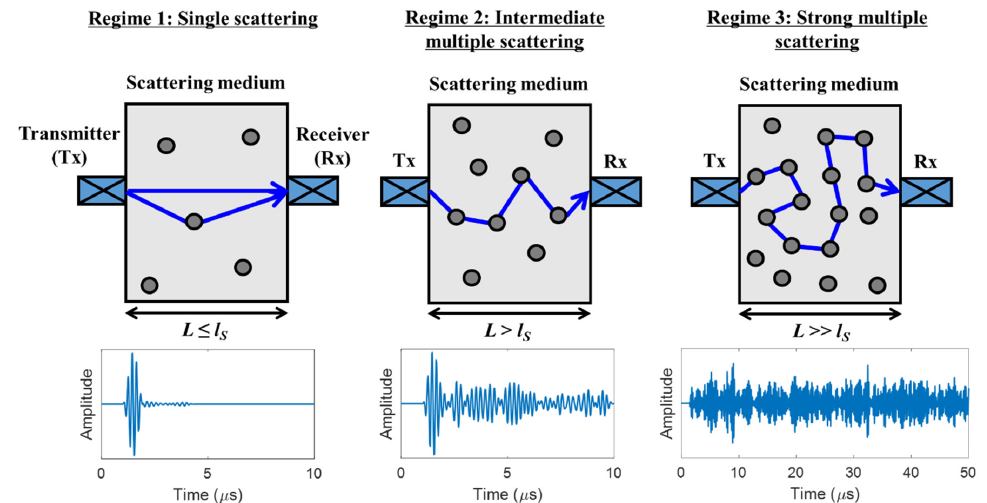
Figure 1. Conceptual illustration of multiple scattering of acoustic waves. An example time-domain signal is displayed below the conceptual illustration of each regime. The scattering mean free path ( l S ) is the characteristic length of the exponential decay of a coherent wave that propagates in its initial direction after taking ensemble averaging over multiple realizations of disorder.